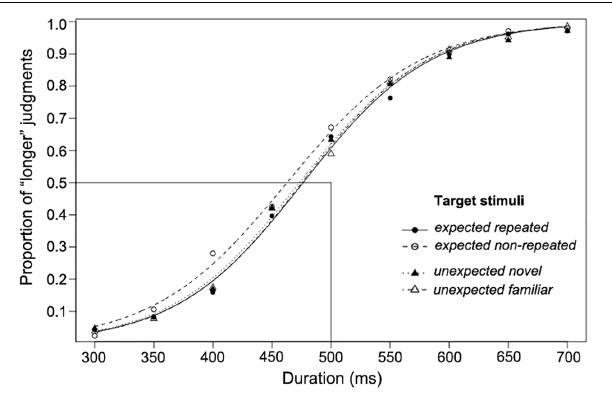
FIGURE 2 | The proportion of “longer” judgments made for each duration and psychometric curves fitted for expected and unexpected target stimulus conditions over 23 participants (Experiment 1).